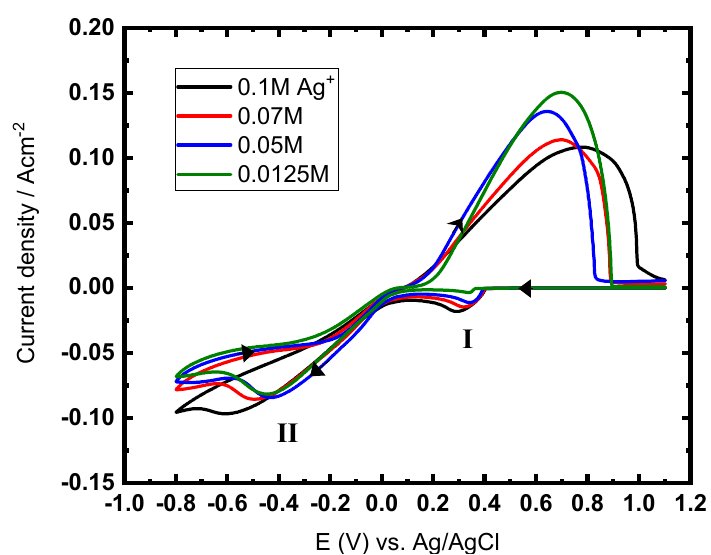
Figure 4. Typical CVs for CuAg reduction with constant Cu 2+ ions concentration (0.5 M) and varying concentrations of Ag + ions, at GCE, 50 mV s − 1 , and at 27 °C.